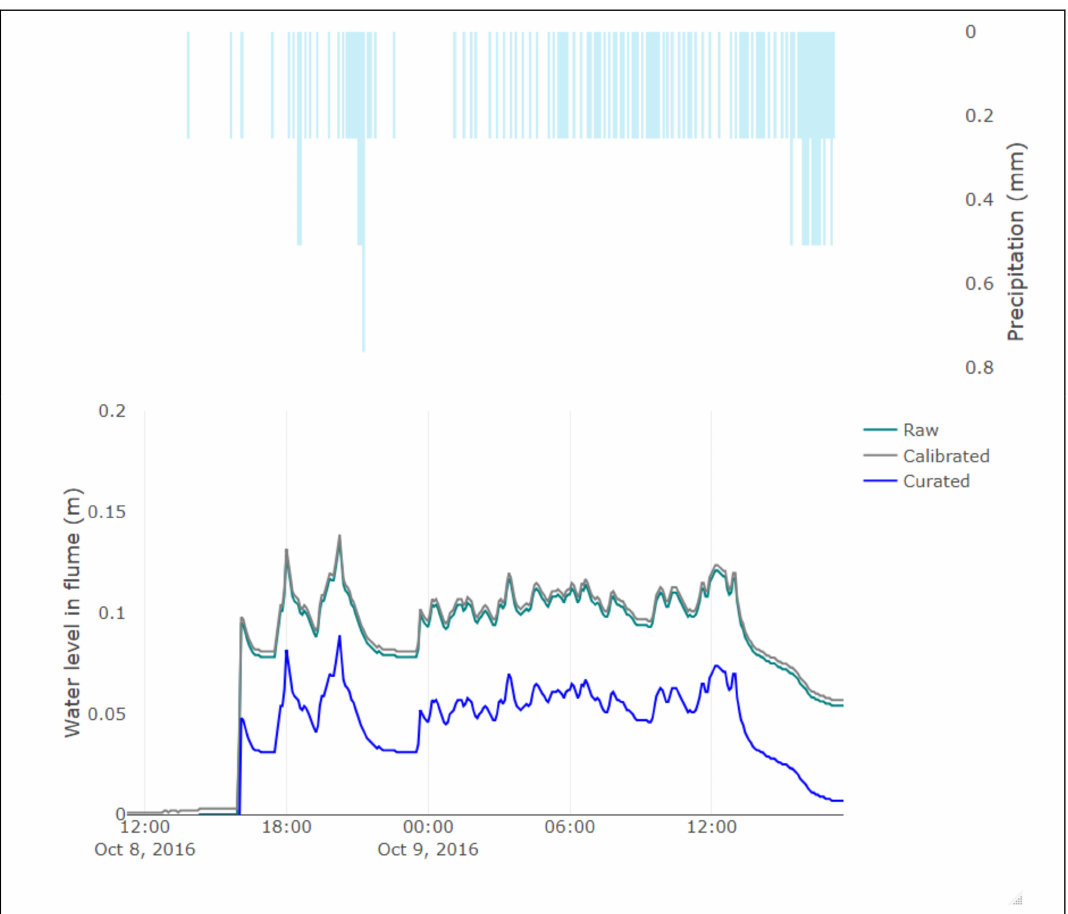
Figure 4. Response of pressure transducer to precipitation event (Event #76) illustrating calibration and data